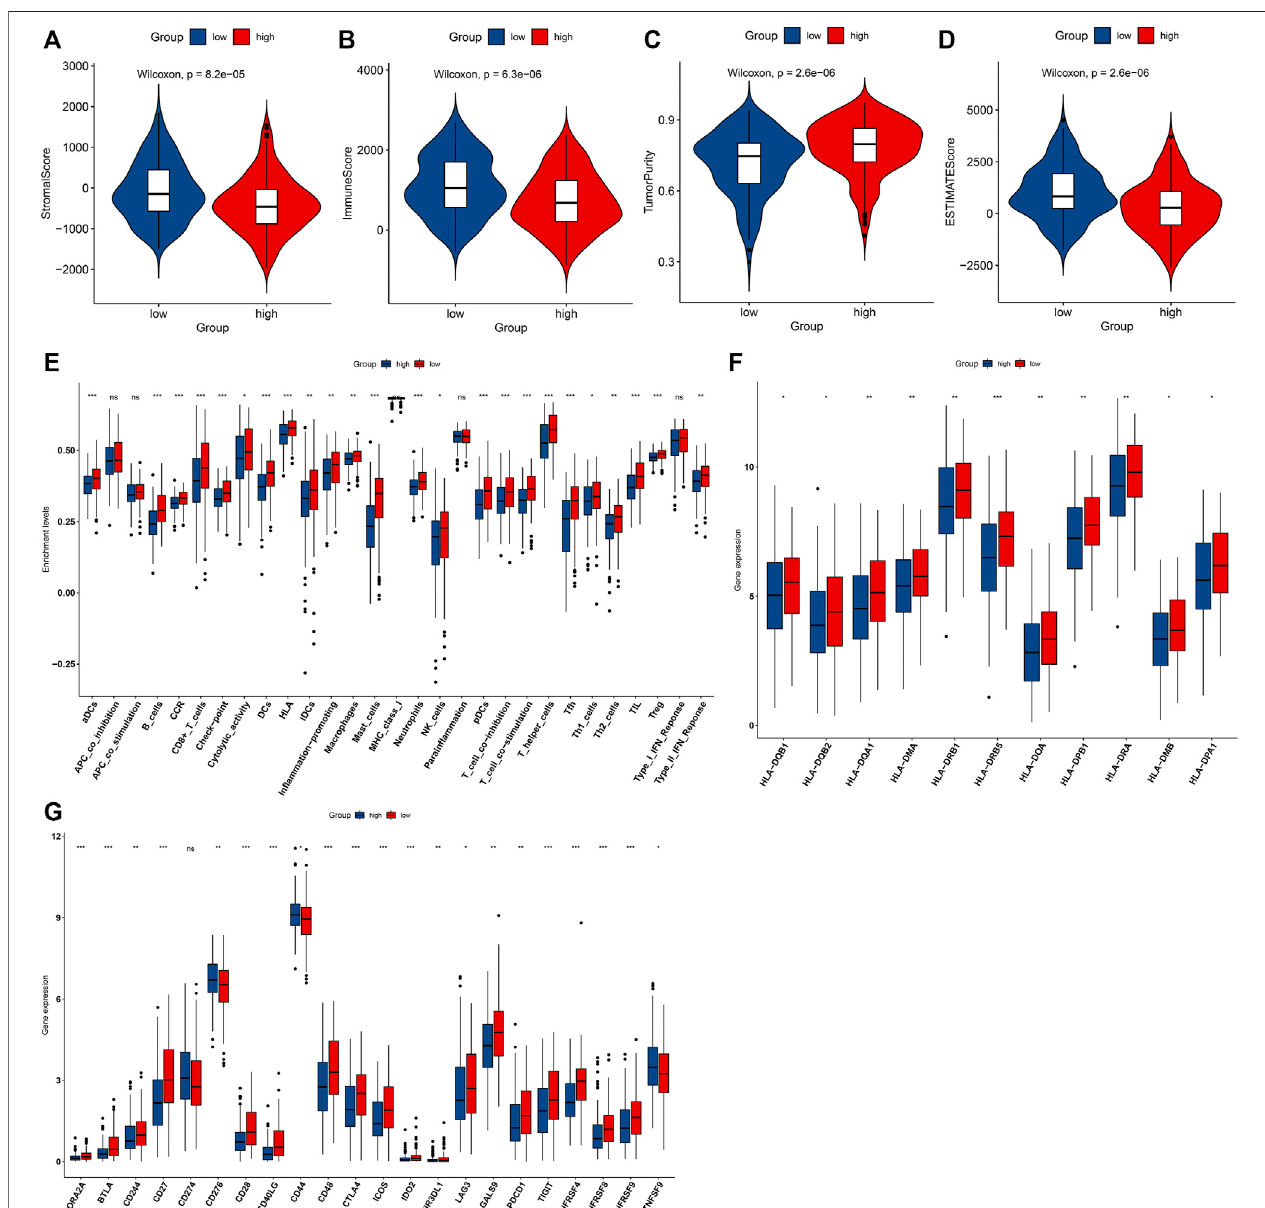
FIGURE 7 | High IRS is in relation to a non fl amed tumor microenvironment in OSCC specimens from the TCGA dataset. (A – D) Comparisons of stromal score, immunescore,tumorpurity,andESTIMATEscoreinhigh-andlow-riskgroups. (E) Comparisonsoftheabundancelevelsofimmunecelltypes,functions,andpathways in high- and low-risk groups. (F,G) Comparisons of mRNA expression of HLA genes and immune checkpoints in two groups. Ns: not signi fi cant; * p < 0.05; ** p < 0.01; and *** p < 0.001.